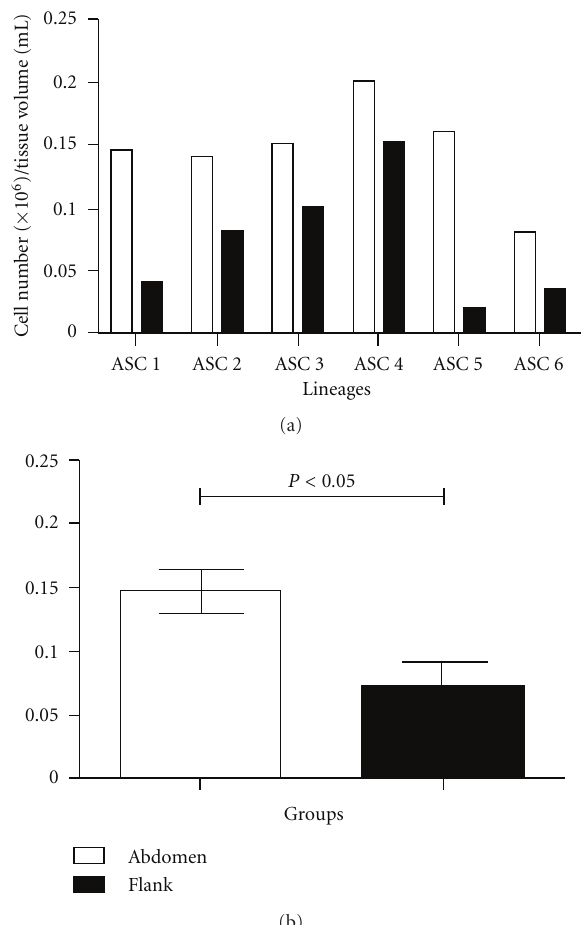
Figure 3: Bar graphs showing (a) cell quantity ( × 10 6 ) per volume of fat tissue (mL) obtained from abdomen or flank from six individuals and (b) Mean and standard deviation from data showed in graph “a”. The Wilcoxon signed-rank test indicates significant di ff erence between the samples ( P < 0 .